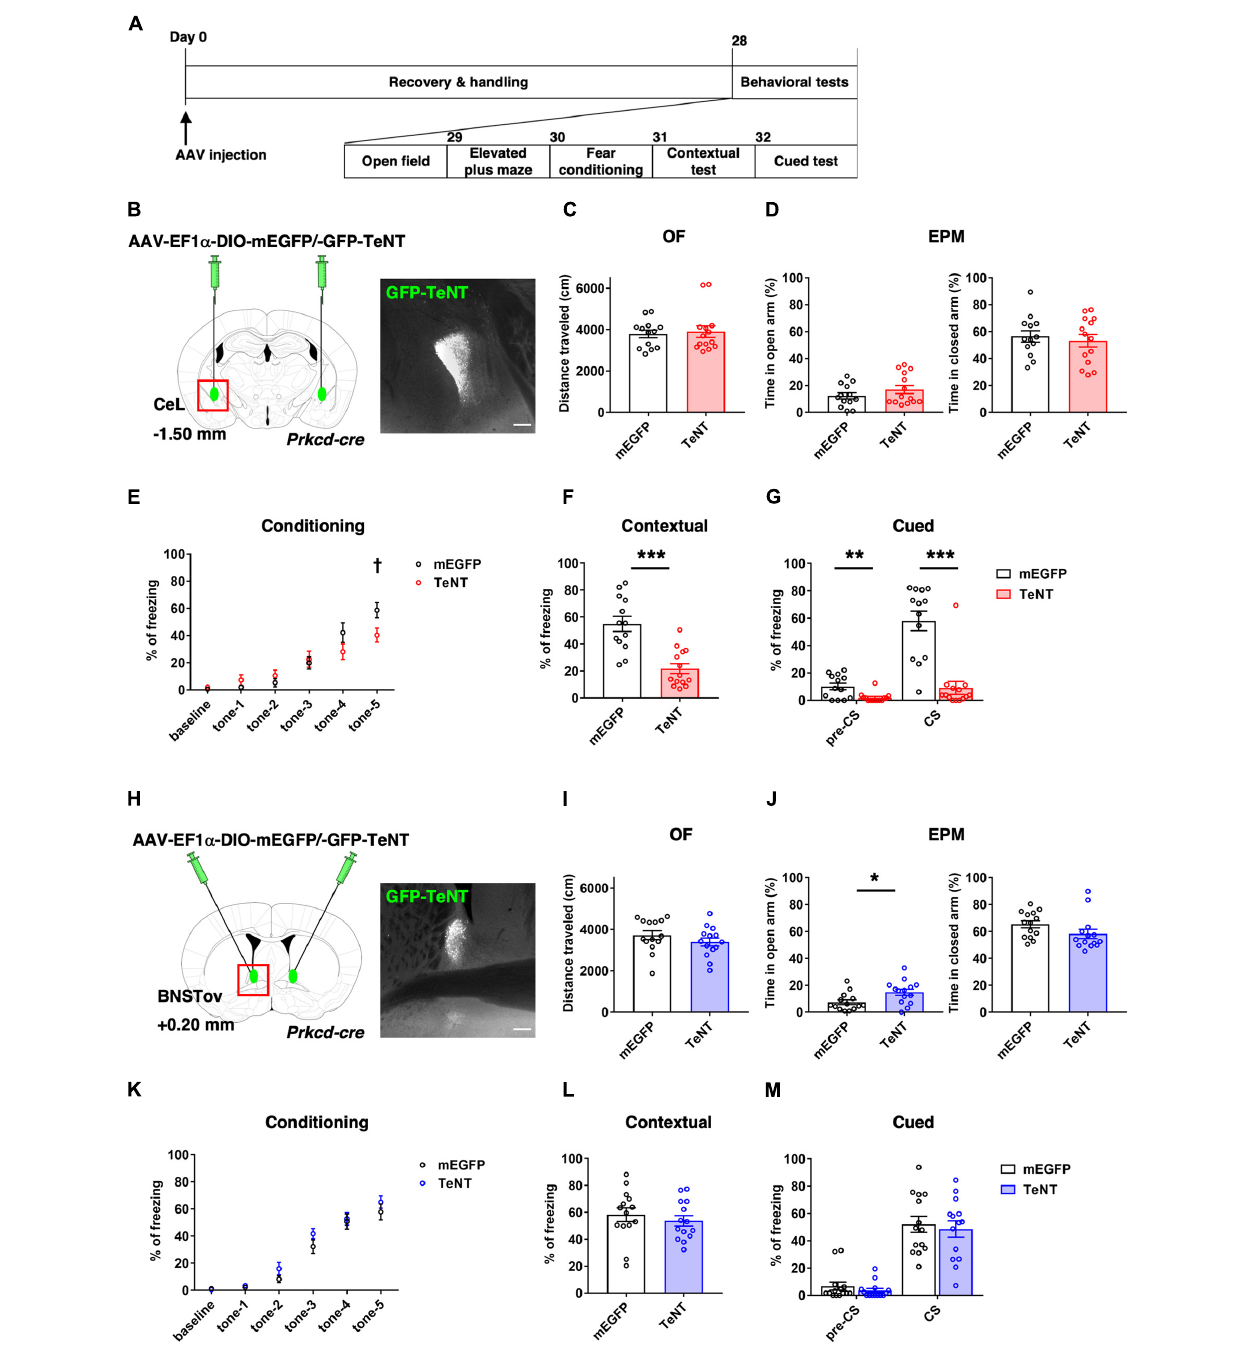
FIGURE 1 | TeNT-mediated synaptic silencing of PKC δ + neurons. (A) Schematic diagram of virus injection and behavioral testing schedule. (B,H) Schematic of bilateral injection of cre-dependent TeNT-expressing AAVs into the CeL ( B , control, n = 13; TeNT, n = 14) and the BNSTov ( H , control, n = 14; TeNT, n = 14), and representative images of the TeNT expression. Scale bars, 200 µ m. (C,I) Total moving distance during 10 min in the OF {unpaired t -test, p = 0.749 for (C) , p = 0.260 for (I) }. (D,J) Percentage of duration in open arm (left) and closed arm (right) during EPM test {unpaired t -test, p = 0.240 and p = 0.614 for (D) , * p = 0.018 and p = 0.113 for (J) }. (E,K) Percentage of time in freezing during fear conditioning of 2 min pre-tone (baseline) and five times of CSs presentation {two-way RM analysis of variance, F interaction [5, 125] = 3.826, ** p = 0.003 for (E) with Holm–Sidak’s post hoc tests, † p = 0.026 at tone-5, F interaction [5, 130] = 0.707, p = 0.619 for (K) }. (F,L) Percentage of time in freezing during contextual test {unpaired t -test, *** p < 0.001 for (F) , p = 0.485 for (L) }. (G,M) Percentage of time in freezing during pre-CS and CS of cued test {unpaired t -test, ** p = 0.003 and *** p < 0.001 for (G) , p = 0.347 and p = 0.673 for (M) }.